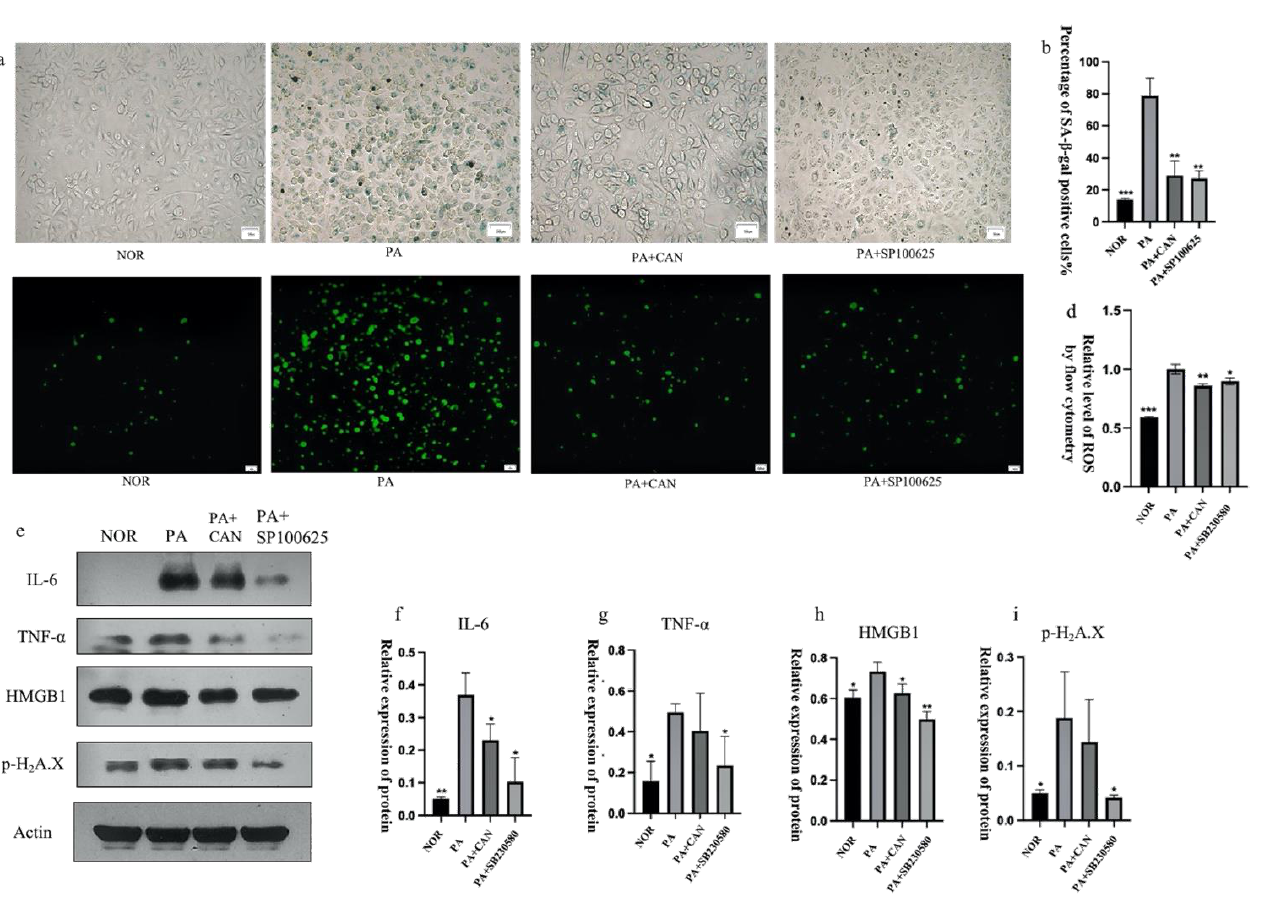
Figure 9. Inhibition of JNK activation alleviated HUVEC cell senescence. ( a , b ) Both CAN (5 µg/mL) and SP100625 (10 µM) reduced the number of β - galactosidase staining - positive cells. ( c ) Both CAN (5 µg/mL) and SP100625 (10 µM) reduced senescence - induced intracellular ROS elevation. ( d ) Results of ROS quantification using flow cytometry. ( e – i ) Both CAN (5 µ g/mL) and SP100625 (10 µ M) reduced the SASP expression levels of senescence-associated proteins p-H2A.X, TNF- α , IL-6 and HMGB1. Data are expressed as the means ± SD ( n = 3); * p < 0.05, ** p < 0.01, *** p < 0.001 vs. PA. All images are magnified to 100 ×